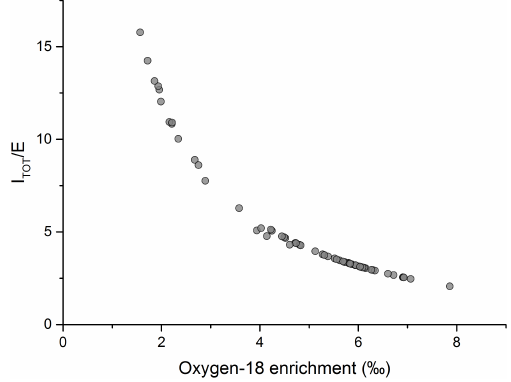
Figure 7. The ratio of total inflow to evaporation ( I TOT /E) as a function of the measured 18 O isotope enrichment ( (cid:49)δ 18 O) for Rokua lakes surveyed during the July–August 2013 sampling cam-